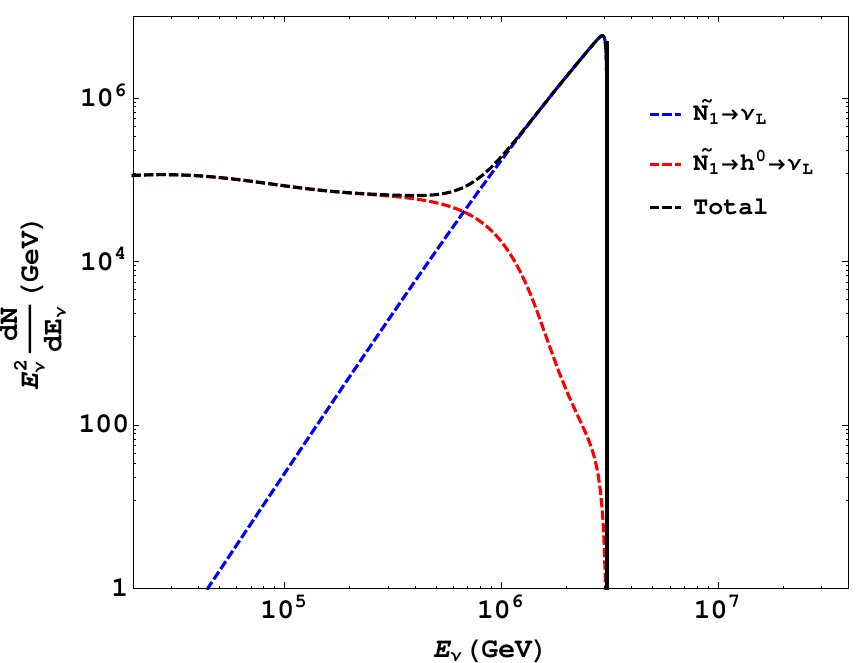
(cid:23) L h 0 , 3 = 2